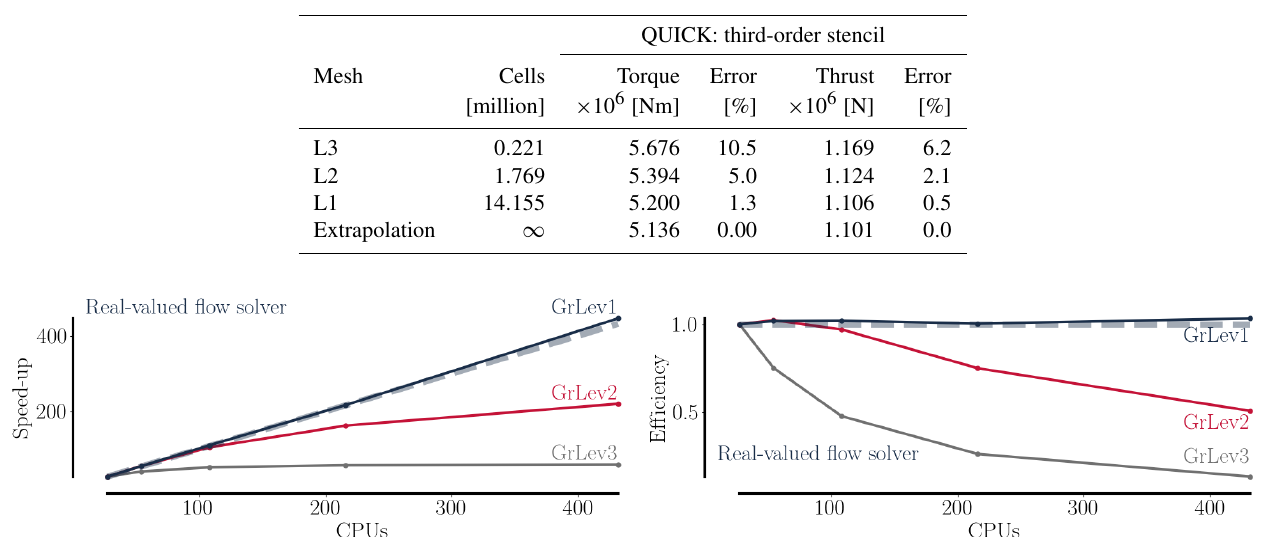
Table 3. Mesh convergence study with error percentages obtained from Richardson extrapolations. The quadratic upstream interpolation for convection kinematics (QUICK) discretization scheme is used for all cases.